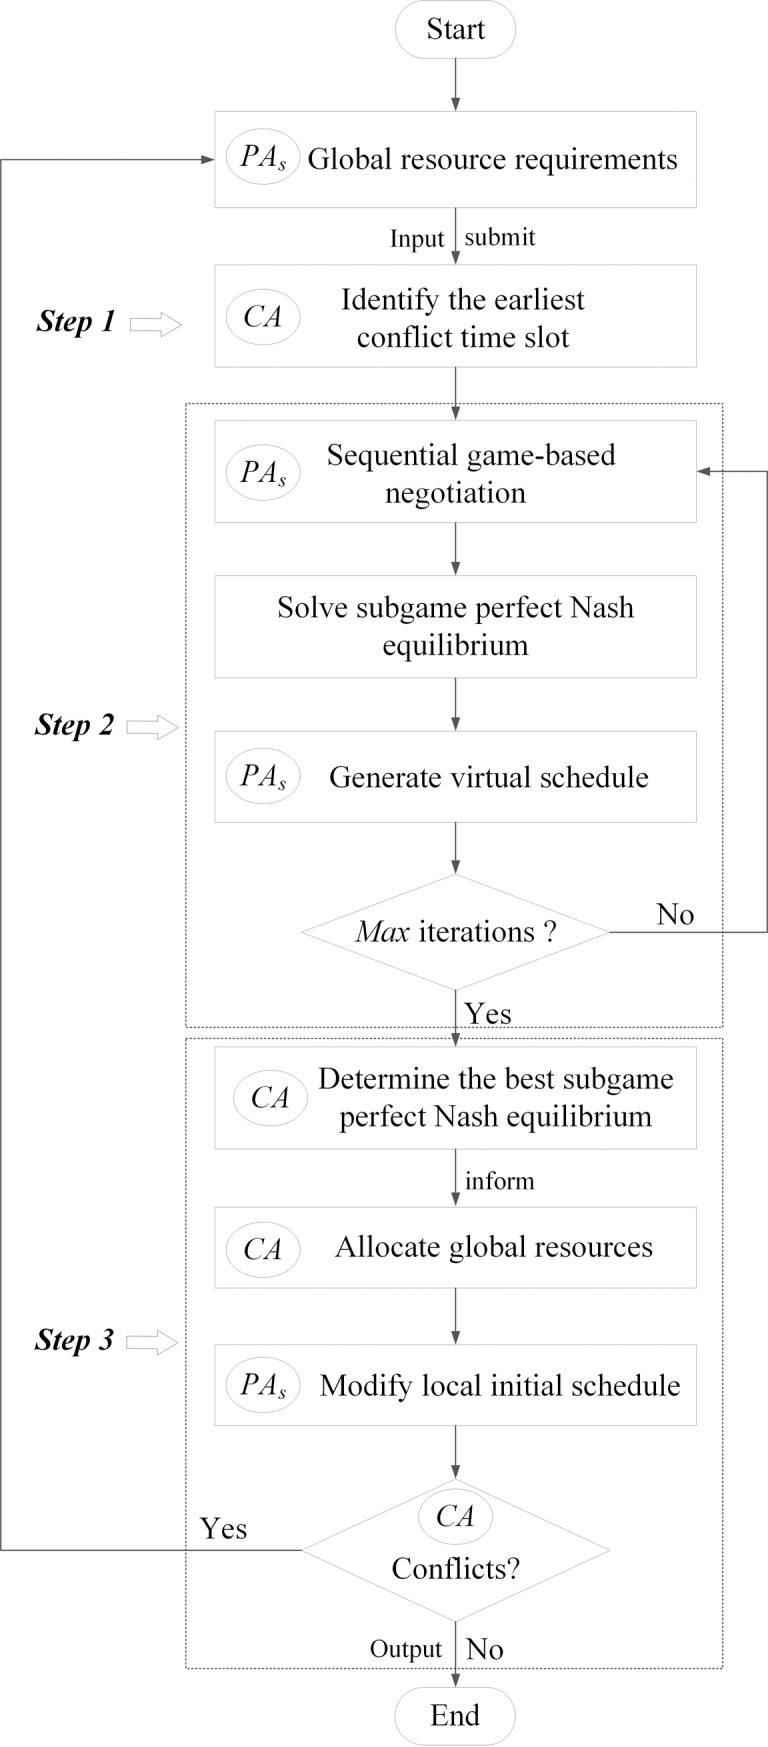
Flowchart of conflicts elimination.